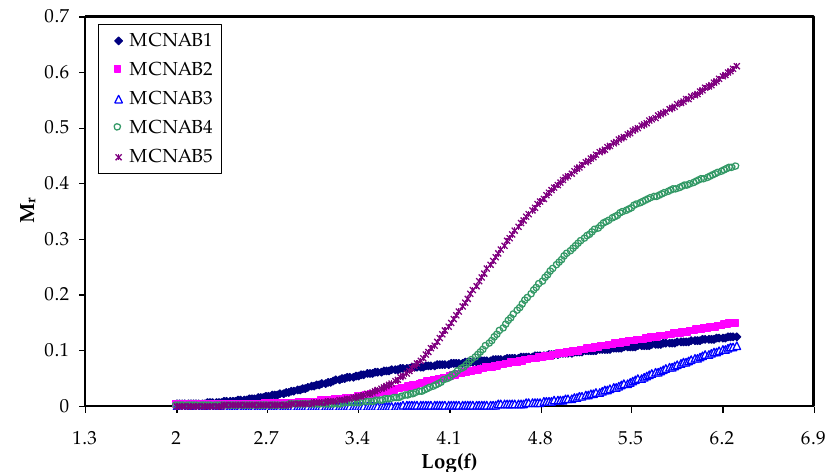
Figure 10. M r against frequency at room temperature for each sample.